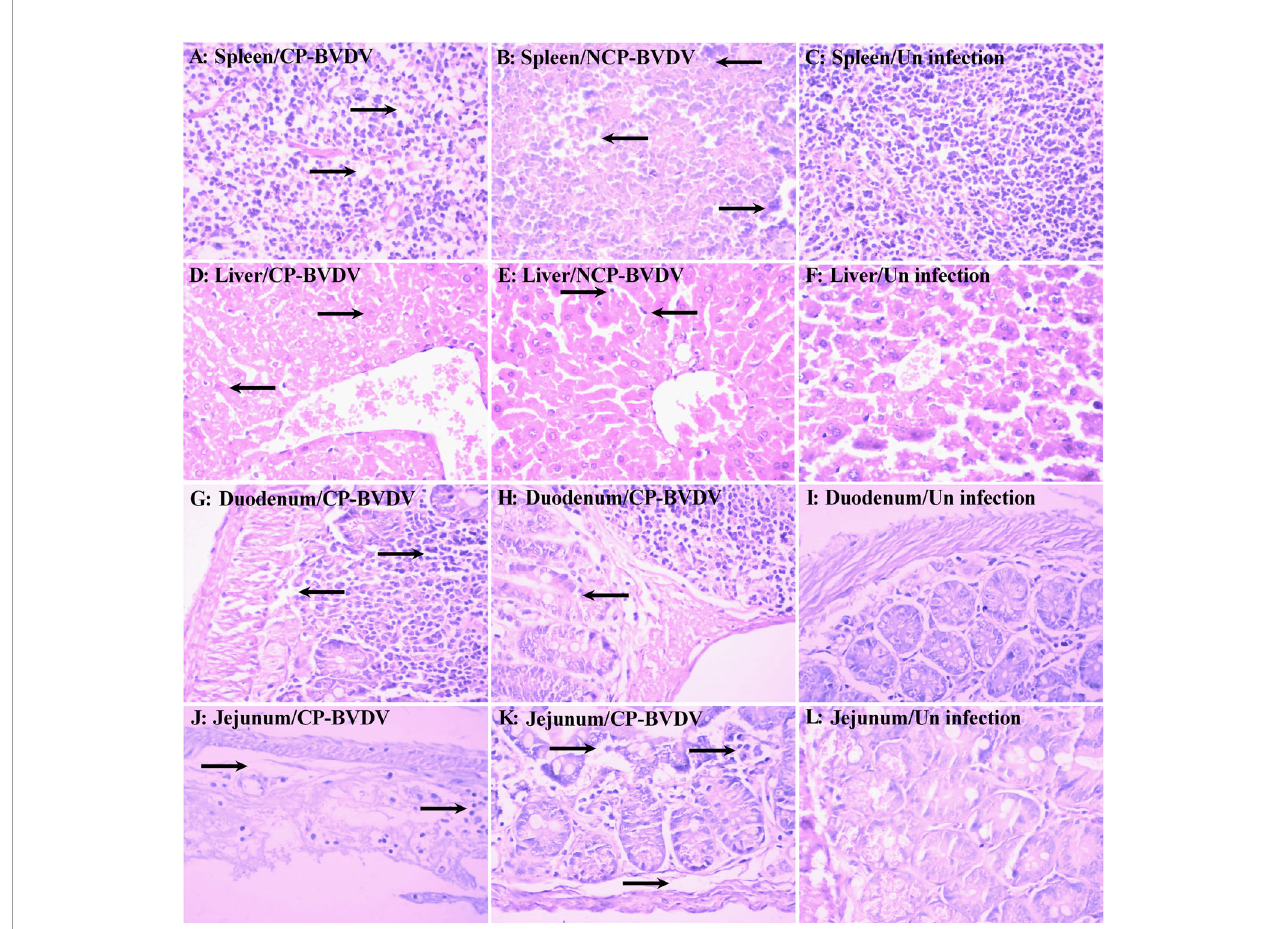
FIGURE 2 | Histopathology of the spleen, liver, duodenum, and jejunum at day 7 of post-infection. Histological lesions were detected in the spleen [ (A) CP BVDV; (B) NCP BVDV], liver [ (D) CP BVDV; (E) NCP BVDV], duodenum [ (G) CP BVDV; (H) NCP BVDV], and jejunum [ (J) CP BVDV; (K) NCP BVDV]. Images of the spleen [ (C) , liver (F) , duodenum (I) , and jejunum (L) of a negative control mouse are also shown (Hematoxylin and eosin, original magni fi cation,